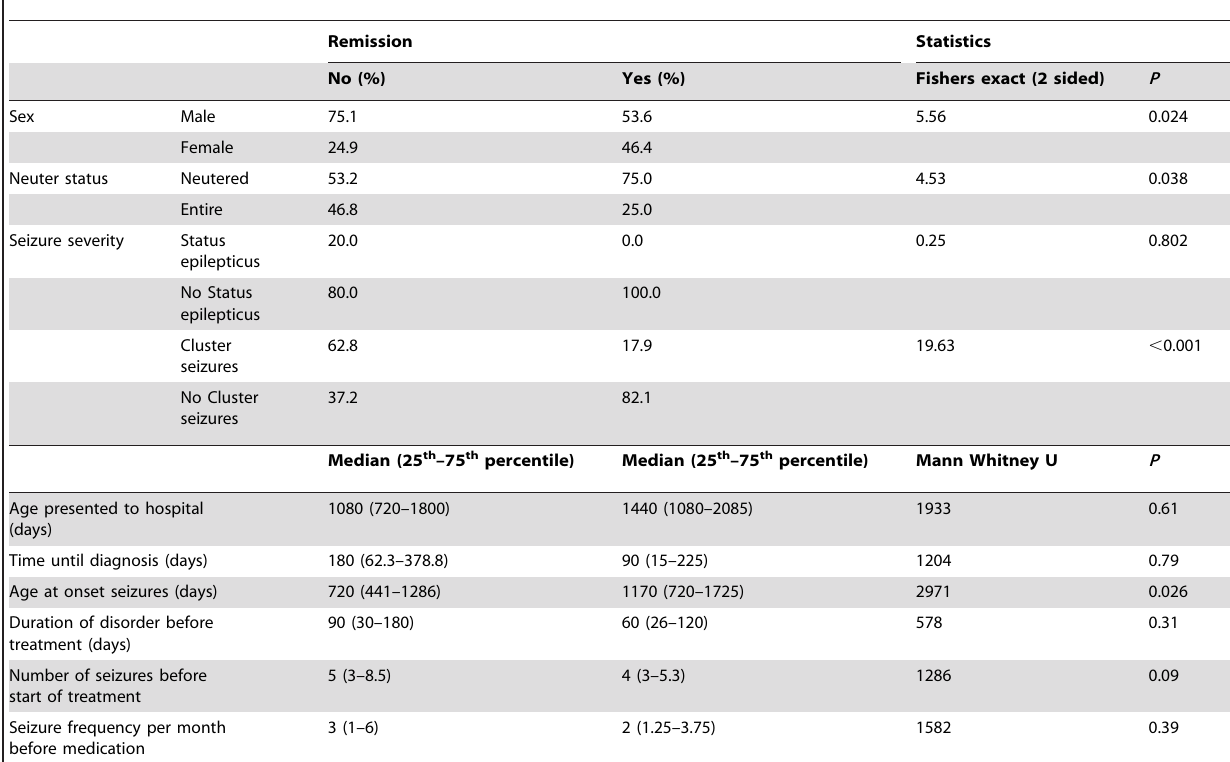
Table 1. Association between clinical variables and being in seizure-free remission in canine epilepsy